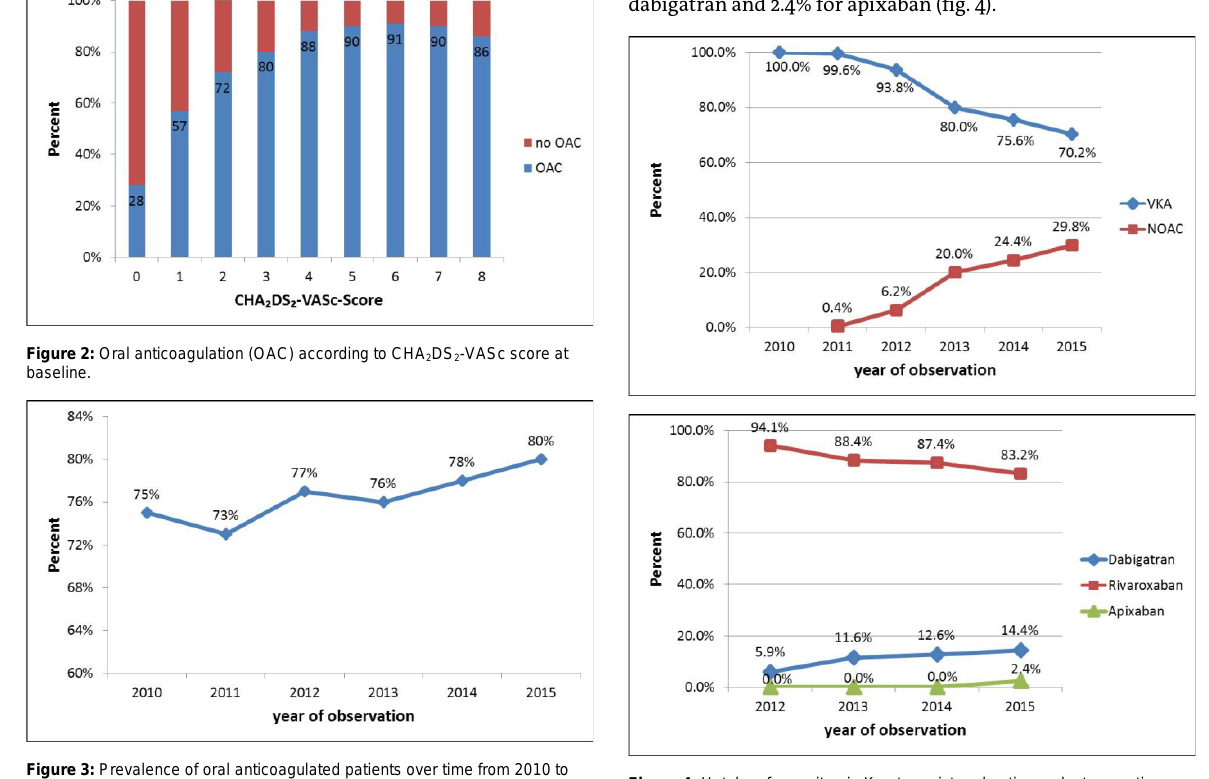
Figure 4: Uptake of non-vitamin K antagonist oral anticoagulants over time from 2010 to 2015; 203 patients with CHA 2 DS 2 -VaSc score of 0 (men) or 1 (women) were excluded from the analyses. NOAC = non-vitamin K antagonist oral anticoagulant; VKA = vitamin K